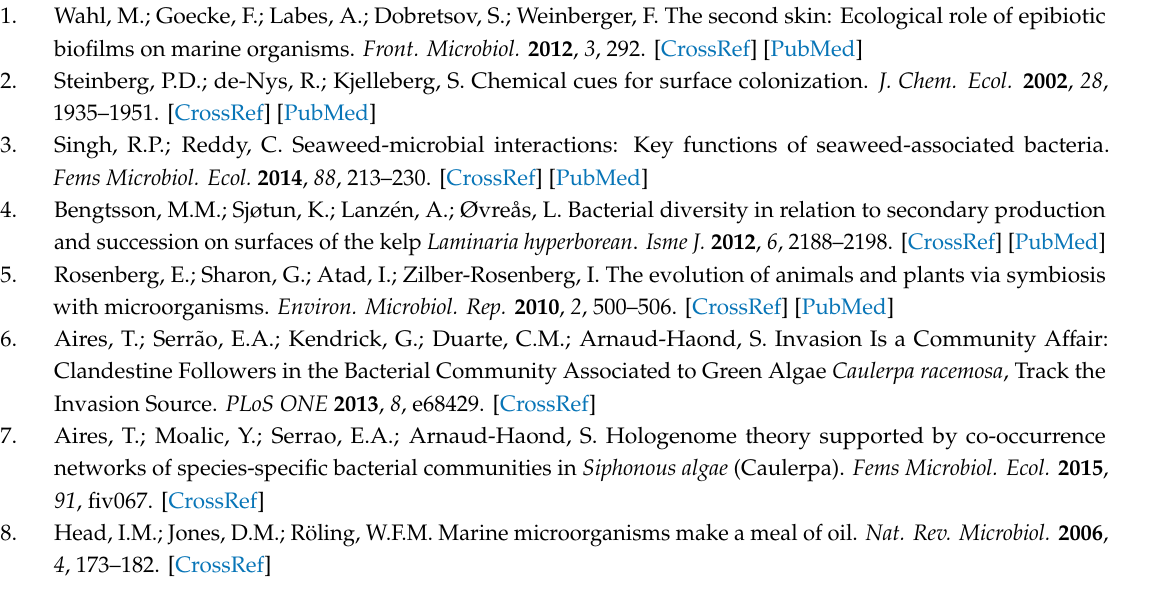
Table S1: Sample Metadata, Table S2: Seasonal measurement of water environmental parameters at the Lagoon of Venice, Table S3: Number of U. laetevirens associated bacterial sequences at phylum and class level, Table S4: Number of bacterial reads, relative abundance %, and average of the relative abundances, associated with U. laetevirens and in the surrounding seawater, Table S5: α -diversity indices of seawater and U. laetevirens associated microbial community at the Lagoon of Venice, Table S6: Classical univariate statistical comparison (order level) between sampling sites, Figure S1: Rarefaction curves show the observed species richness with increasing sequences depth of SAMCs, Figure S2: Seaweed associated microbial communities (SAMCs) at the phylum level across LV sampling sites, Figure S3: SAMCs at the class level across LV sampling